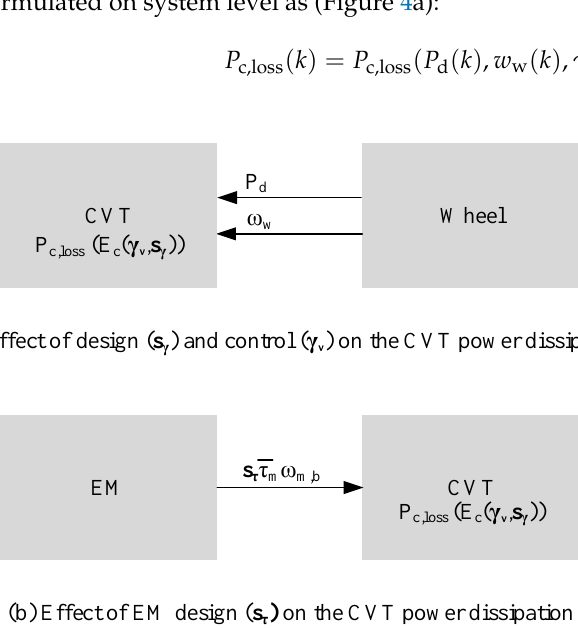
Figure 4. Convex modeling of the CVT, where τ m represents the maximum EM torque and ω m,b the EM base